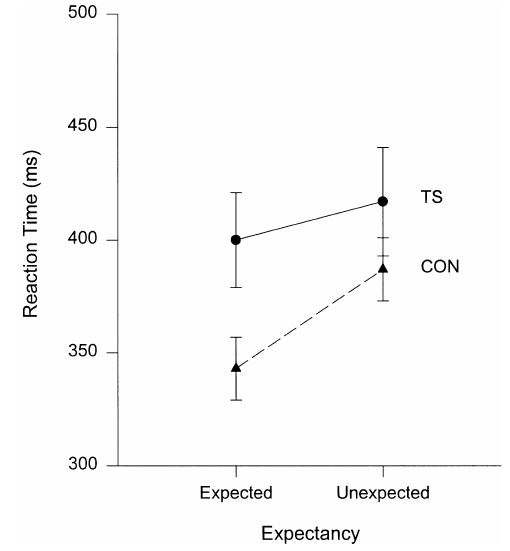
Fig. 2. Mean reaction time (ms) as a function of Expectancy (ex- pected/ unexpected events) for both Tourette’s syndrome (TS) pa- tients and controls (CON). SE bars